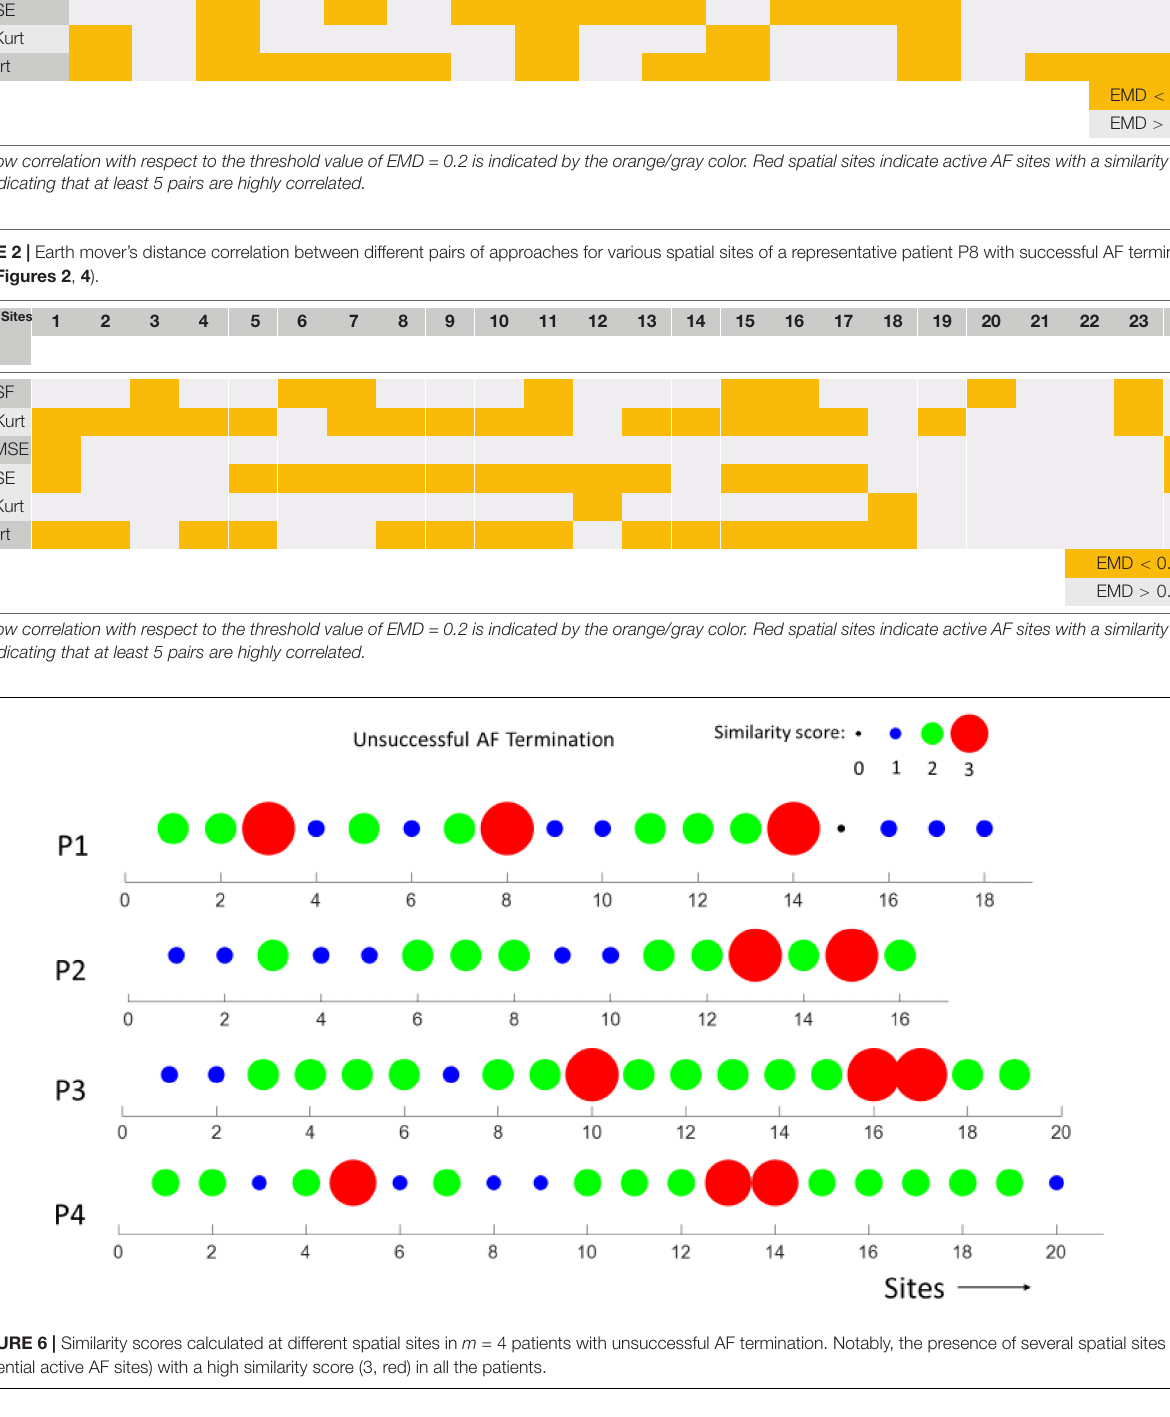
Frontiers in Physiology |